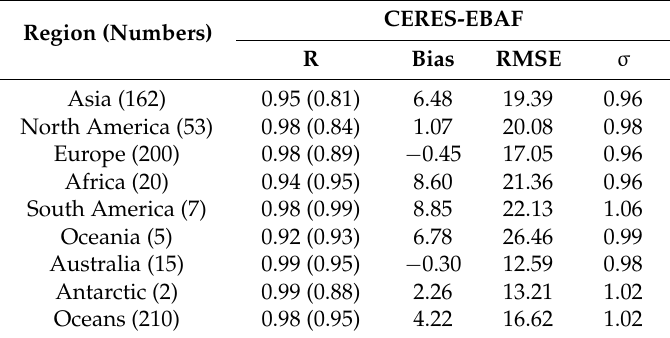
Table 6. Evaluation of the monthly R s for CERES-EBAF data using surface measurements in various sub-regions from 2001 to 2009. The numbers of observational stations are shown in brackets in the first column. The numbers in the brackets in the second column are the correlation coefficients after removing the seasonal cycle. Units are W/m 2 for bias and